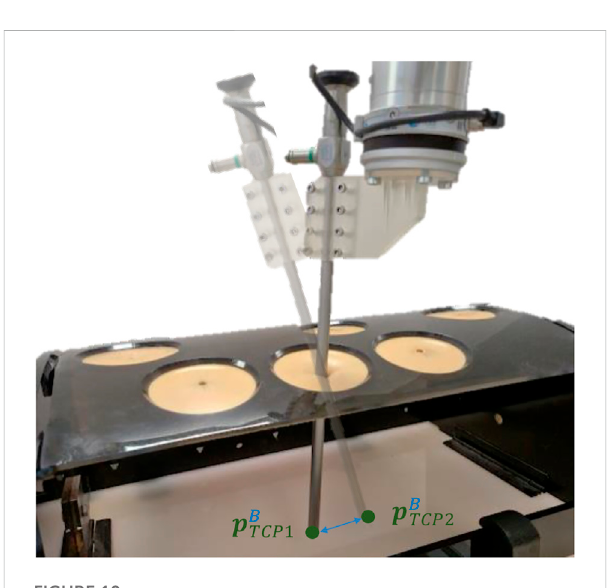
FIGURE 10 Linearmovementperformedtotesttheffpivotingcontrolforthe Cartesian movement of the